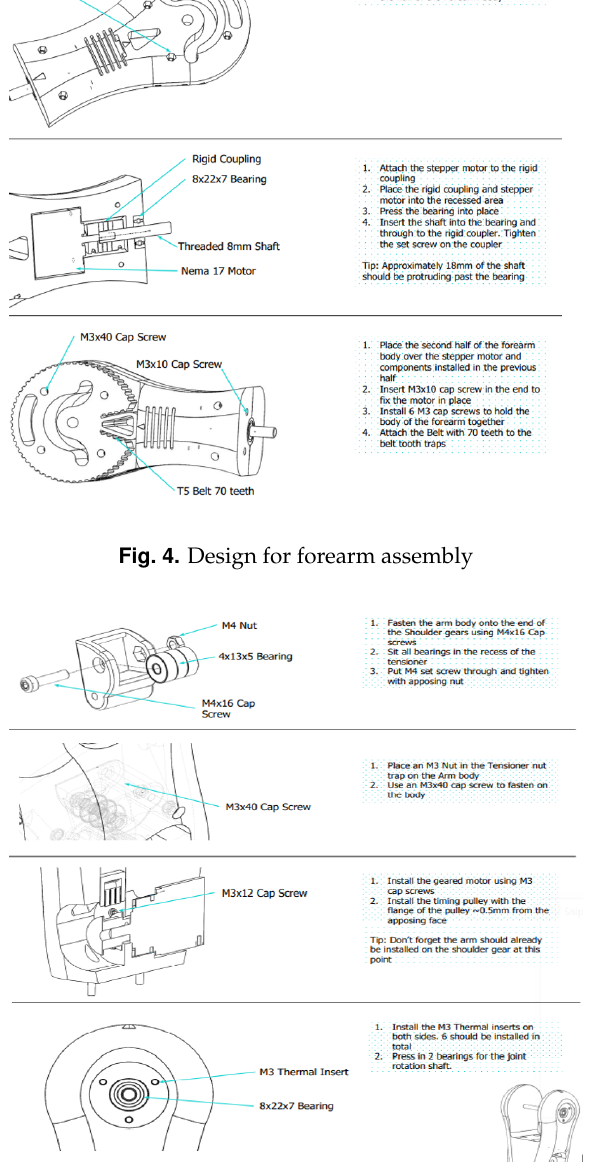
3.2.2. Algorithm to control the waste sorting